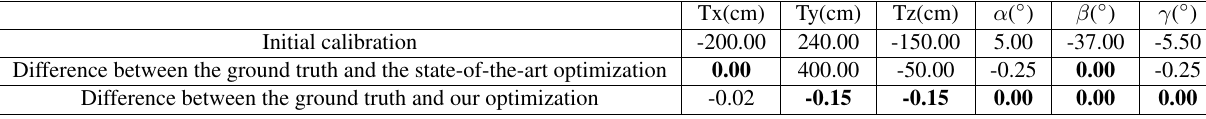
Table 4: Optimization of the calibration of synthetic point cloud #1